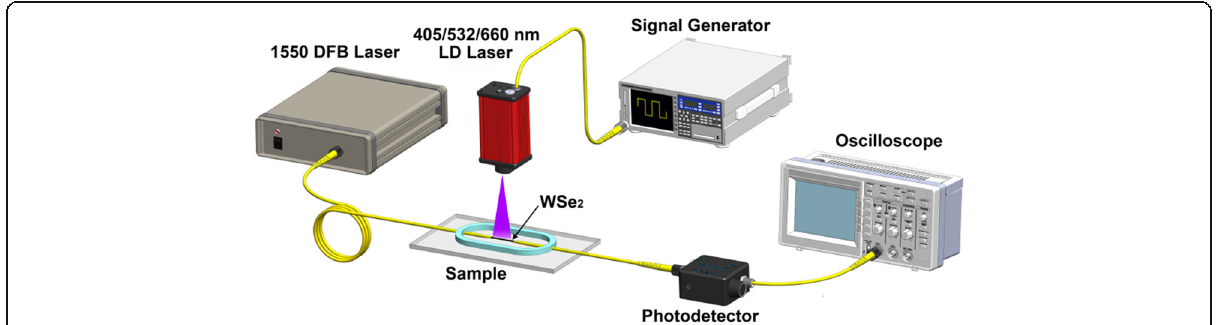
Fig. 12 Experimental setup of the transient response